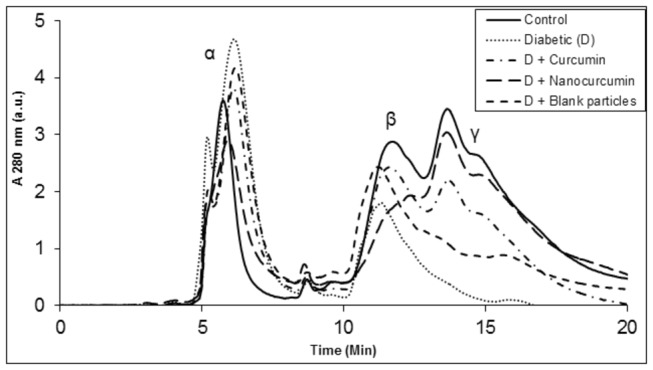
The effect of curcumin and nanocurcumin on crystallin distribution in the soluble protein fraction of rat lens.Soluble protein was loaded on TSK-G3000 SWXL gel filtration HPLC column and protein peaks were detected at 280 nm. Peaks representing α-, β- and γ- crystallins are indicated at their respective positions.